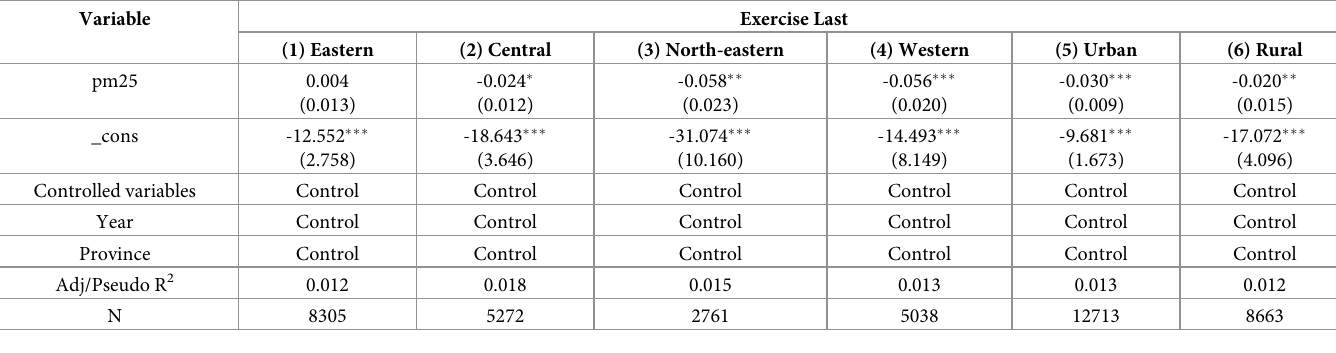
Table 7. Heterogeneity test